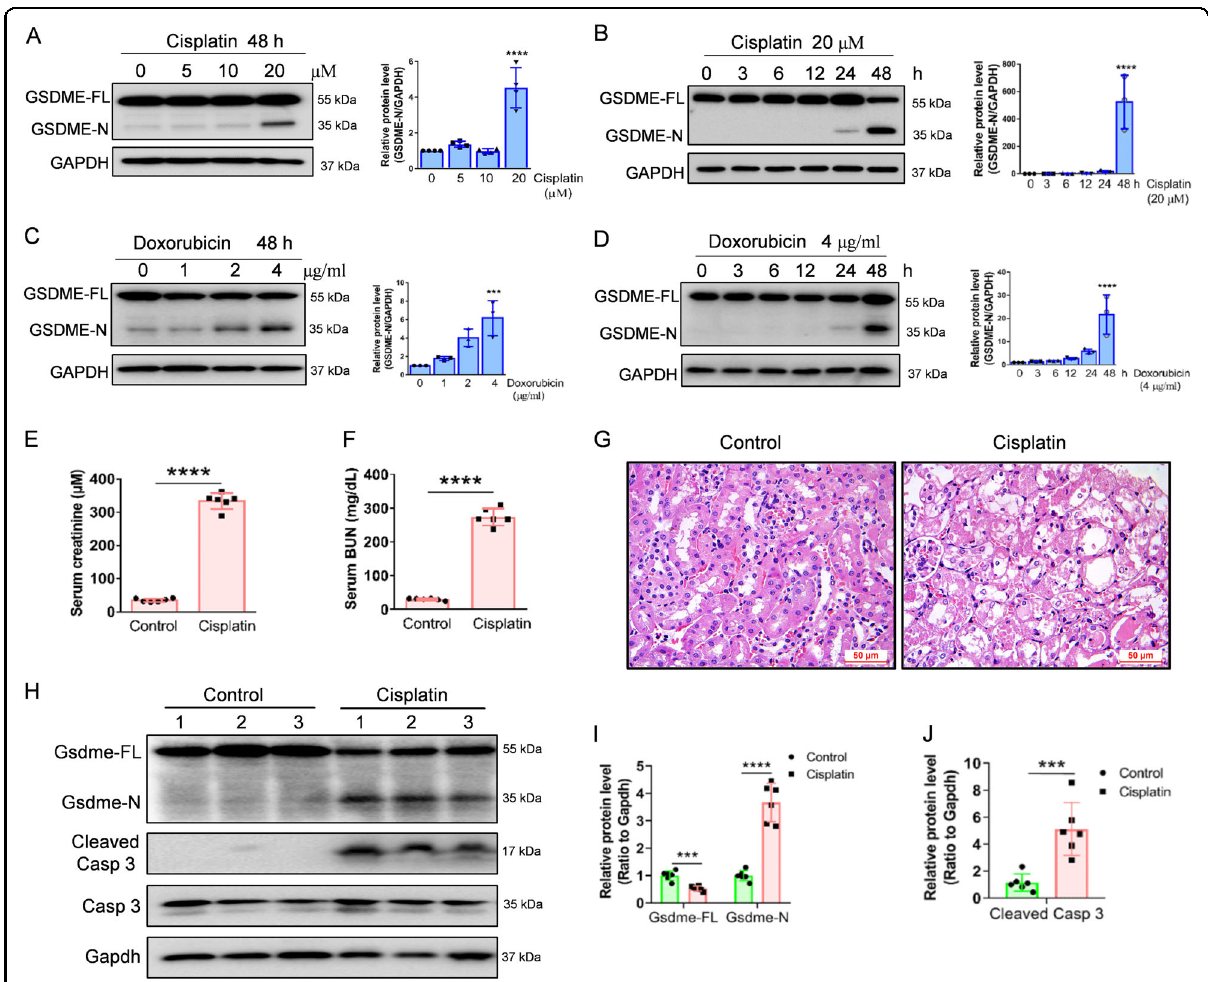
Fig. 1 Cisplatin or doxorubicin induces cleavage of GSDME in renal tubular epithelial cells in vitro and in vivo. A , B Western blot analysis of GSDME in HK-2 cells treated with various concentrations of cisplatin (0, 5, 10, and 20 μ M) for 48 h, and with 20 μ M cisplatin for different times (0, 3, 6, 12, 24, and 48 h). C , D Western blot analysis of GSDME in HK-2 cells incubated with various concentrations of doxorubicin (0, 1, 2, and 4 μ g/ml) for 48 h and 4 μ g/ml doxorubicin for different times (0, 3, 6, 12, 24, and 48 h). E , F Serum creatinine and BUN detection of normal and cisplatin-treated mice after 72 h. G Hematoxylin – Eosin (HE) staining of control and cisplatin-treated mice. Scale bar, 50 μ m. H – J Western blot analysis of Gsdme in mice and caspase 3 in control and cisplatin-treated mice. All data are presented as means ± SD from at least three independent experiments ( n = 3 for in vitro experiment; n = 6 for in vivo experiment). *** p < 0.001 versus control group, **** p < 0.0001 using two-tailed Student ’ s t